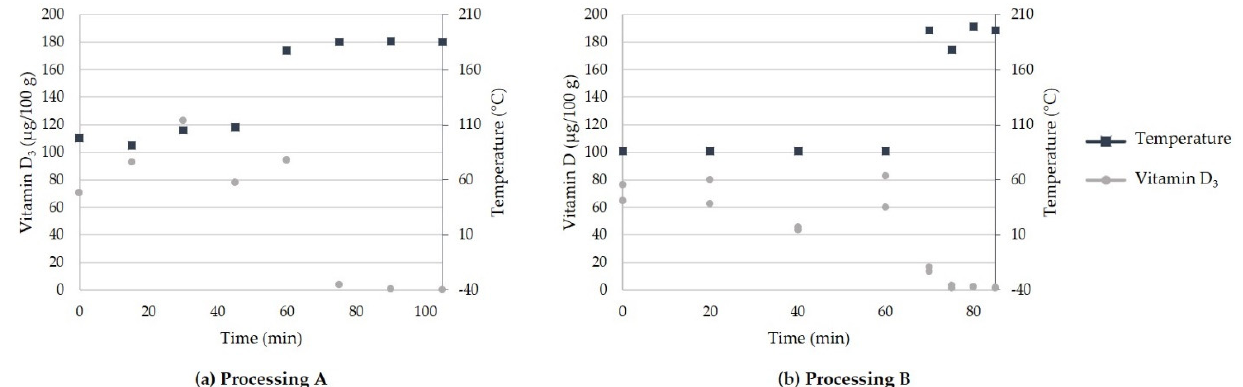
Figure 2. Stability of vitamin D 3 during the thermal processing of UVB-exposed (95 vitD 3 J/m 2 ) pork rind. ( a ) Processing A: Roasting in the oven under hot air in 2 intervals (100 °C, 60 min and 180 °C, 45 min). ( b ) Processing B: Sous vide (85 °C, 60 min) followed by roasting in the oven (200 °C, 25 min). Vitamin D 3 (µg/100 g) content reads from the left y -axis, while the temperature reads from the right y -axis. The values for each single determination at each sampling point are presented.